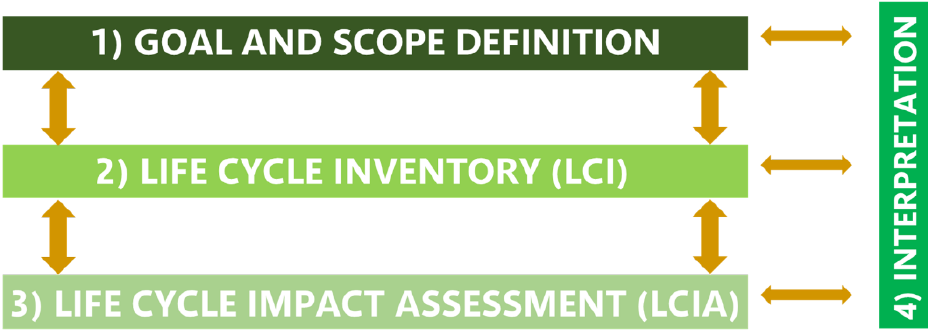
Figure 1. The four phases of the life cycle assessment.